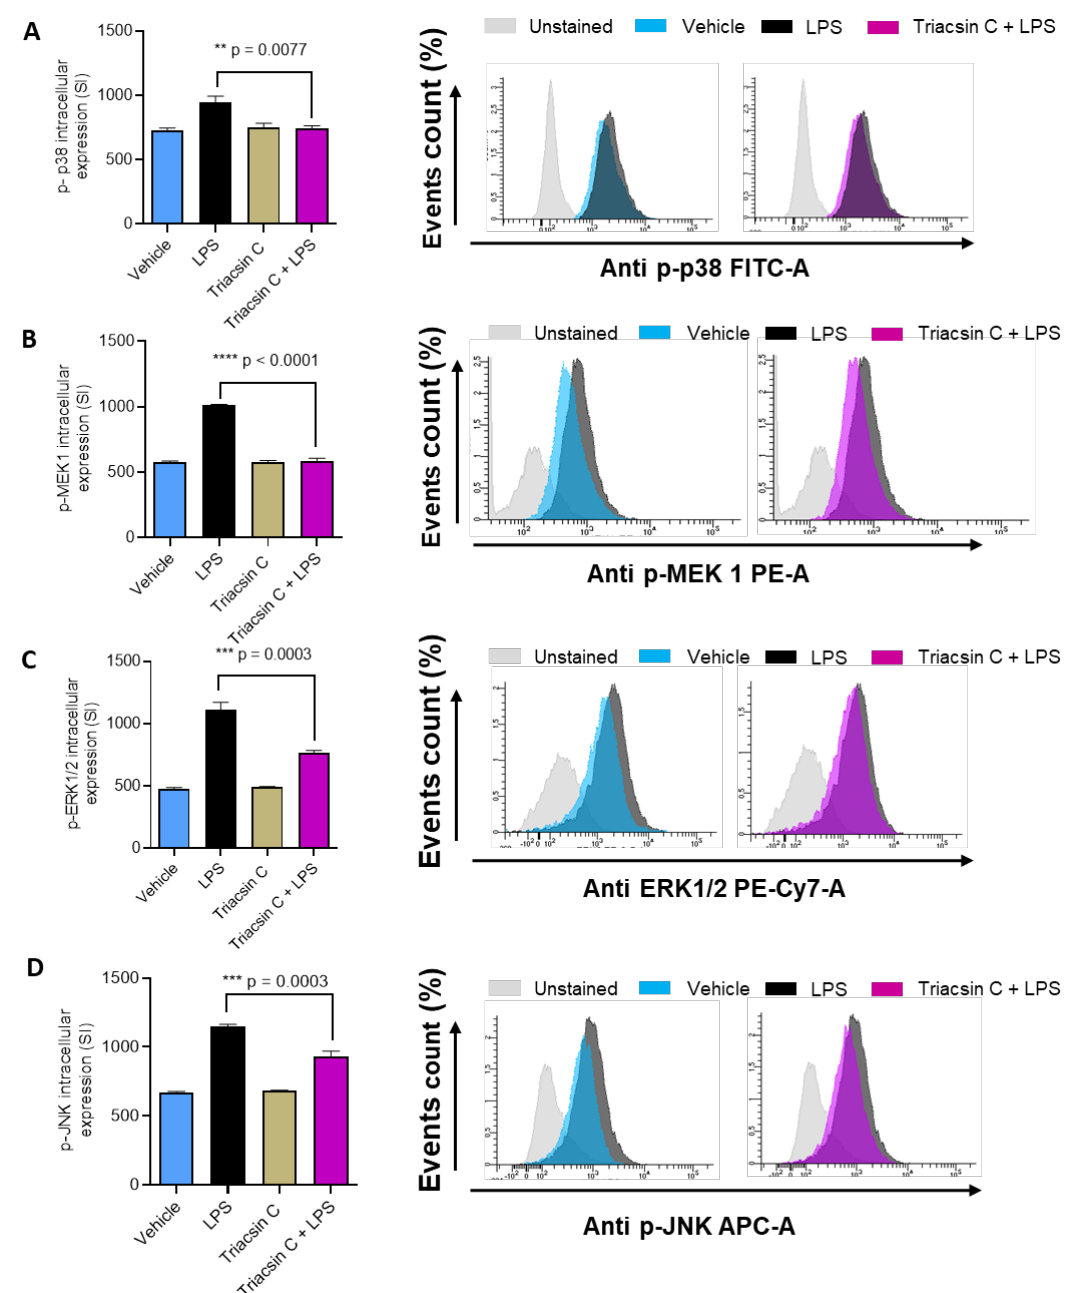
Figure 3. Mitogen-activated protein kinase (MAPK) signaling molecules activation in LPS-treated MDA-MBA-231 was inhibited by triacsin C. MDA-MBA-231 cells were pretreated with ACSL1 inhibitor (Triacsin C: (1 µ M) or vehicle for 1 hr and then incubated with LPS for 15 min. There is no di ff erence between vehicle and Triacsin C cells. Therefore, for the histogram, we used only vehicle-treated cells. ( A – D ) The phosphorylation of p38, extracellular signal-regulated kinase (ERK1 / 2) and c-Jun NH2-terminal kinase (JNK) was determined by flow cytometry presented in the form of staining intensity and representative histograms. The data are representative of three independent experiments. All data are expressed as mean ± SEM (n ≥ 3). ** p < 0.01, *** p < 0.001, **** p < 0.0001 versus